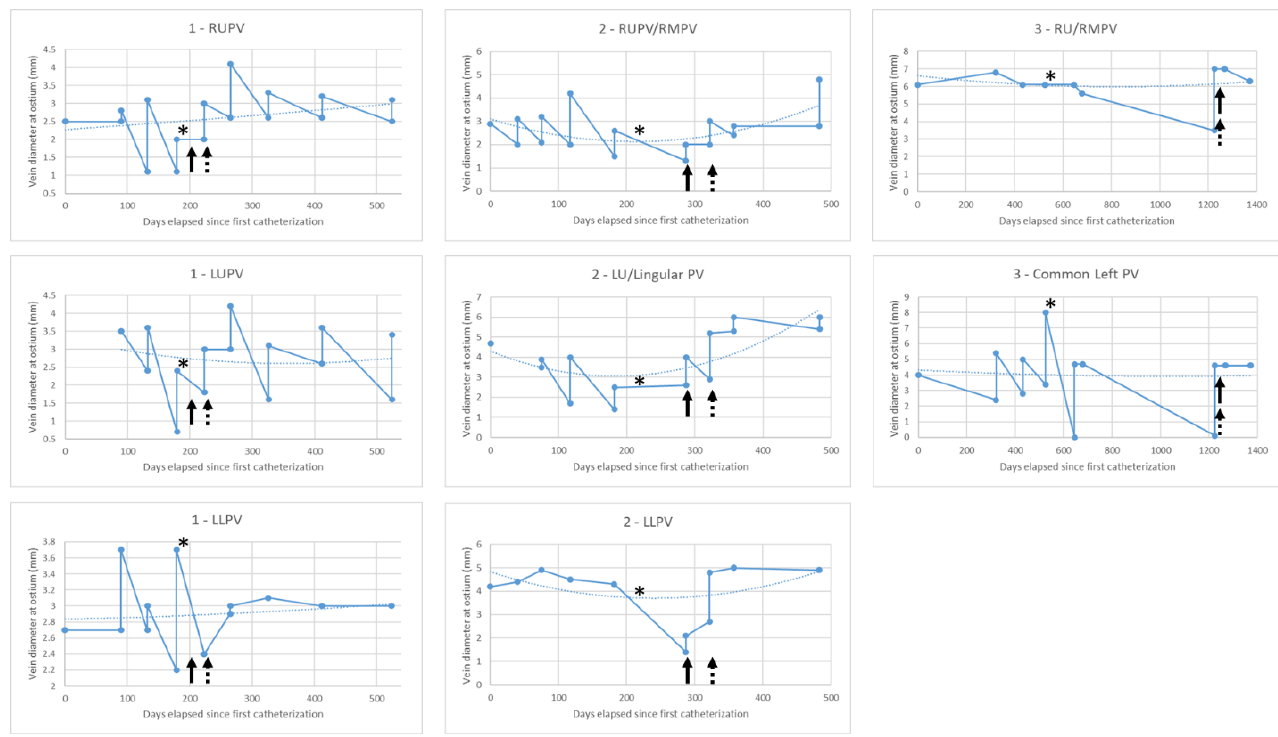
Figure 1. Temporal scatter plot of diseased pulmonary veins over time. The minimum osteal diameter of each of the eight diseased vessels among three patients was recorded based on angiography performed at catheterization. Day 0 was set as the date of the first catheterization where PVS was diagnosed. Any vertical jump represents an acute increase in diameter related to balloon dilation or stent placement. Though not detailed for each patient and each catheterization, our practice is to utilize the largest balloon that the distal vessel can accommodate in the dilation of a stenotic pulmonary vein and to eliminate any waist in the balloon; when a waist could not be eliminated, cutting balloon angioplasty was employed to facilitate dilation. Any fall in diameter over time represents disease recurrence or progression. A second-order polynomial trendline is displayed for each vessel. * = time of surgical intervention; solid black arrow = time of initiation of imatinib; dashed black arrow = time of initiation of sirolimus.